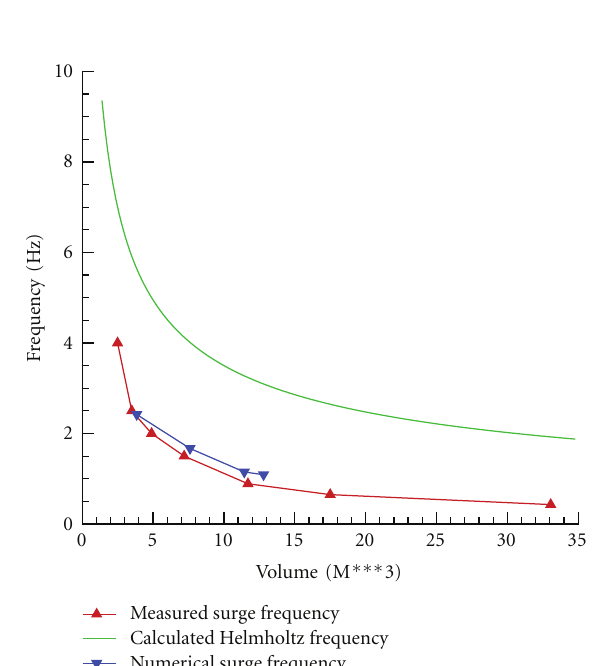
Figure 11: Numerical surge performances with two di ff erent compressor lengths at B = 0 . 67.